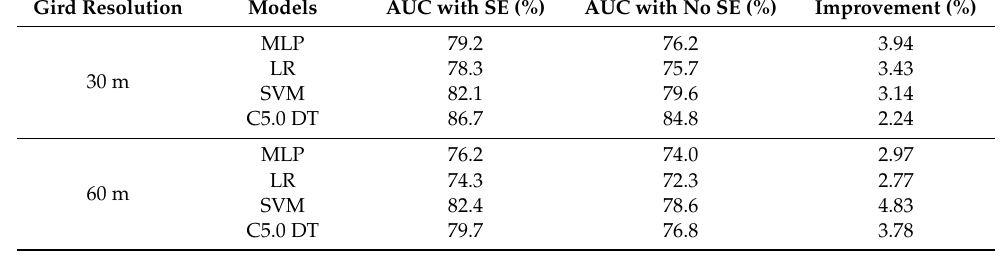
Table 4. Performance of each LSP model with resolutions of 30 m and 60 m.